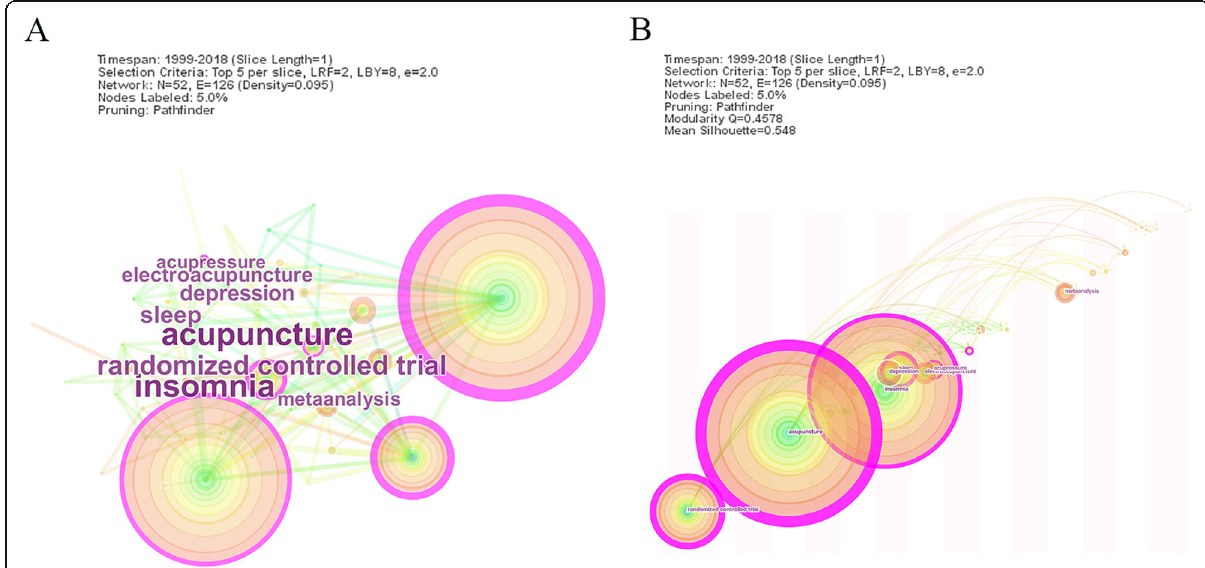
Fig. 5 Keyword map of acupuncture for insomnia. a The network map of keyword related to acupuncture for insomnia. b The timezone view of keyword related to acupuncture for